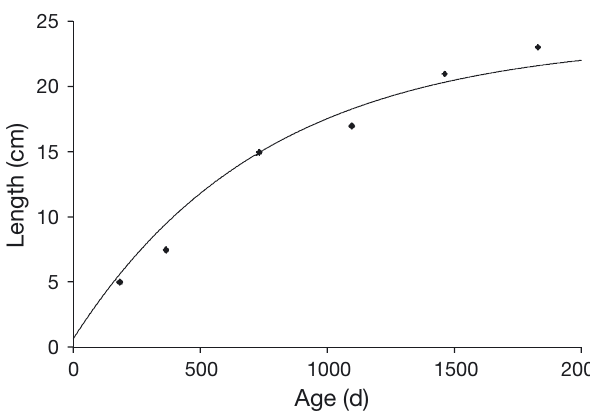
Fig. 1. Simulation of sea cucumber ( Apostichopus japonicus ) length using the primary parameters of the dynamic energy budget (DEB) model (line). Dots are observations and the line is the fitted growth